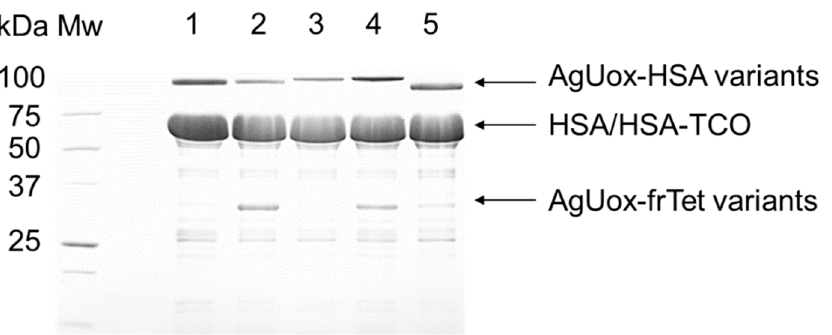
Figure 5. SDS-PAGE analysis of AgUox-HSA conjugate variants. The protein gel was visualized using Coomassie blue staining. Lanes: MW, molecular weight marker; 1, AgUox-HSA from Ag1 variant; 2, AgUox-HSA from Ag6 variant; 3, AgUox-HSA from Ag8 variant; 4, AgUox-HSA from Ag10 variant; 5, AgUox-HSA from Ag12 variant.